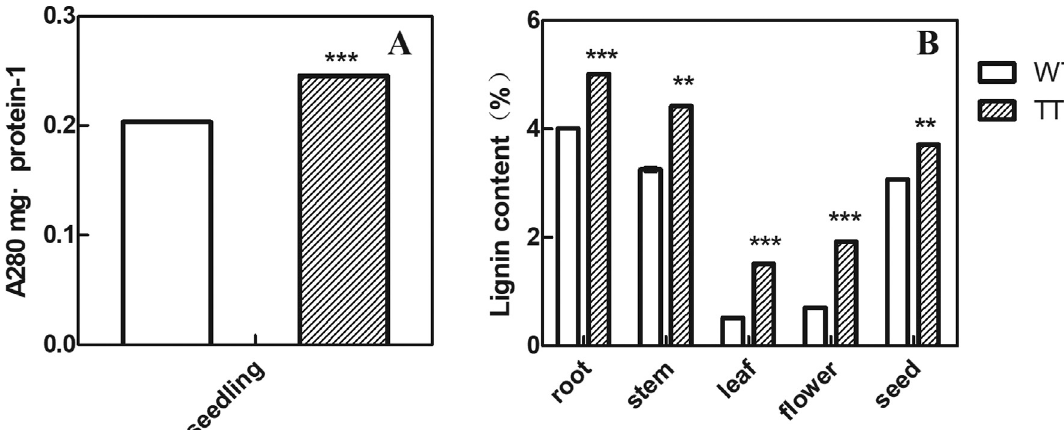
Figure6 -LignincontentinWTandTTplants.Wholeseedlingswereobtainedat15days(A),anddifferenttissueswereobtainedat120days(B),respec- tively. The values and error bars indicate the mean and standard deviations (SD) (n = 3), respectively, from three independent measurements. ** and *** indicate significant differences in comparison to the WT plants at p < 0.01 and p < 0.001, respectively (Student’s t- test).